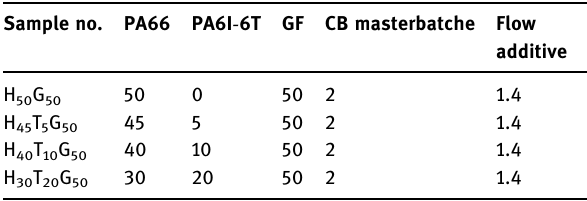
Table 1: Test formula of PA66/PA6I - 6T/GF